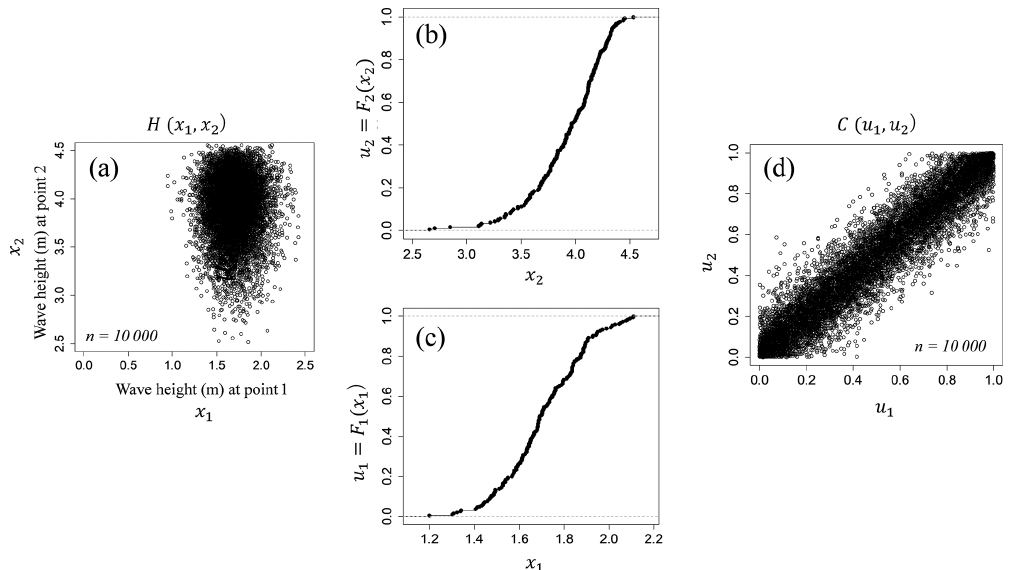
Figure 3. A simple synthetic example of a copula in a bivariate case. (a) Joint distribution; (b, c) are distribution functions of each variable (marginal distribution) and (d) is a copula distributed over [0,